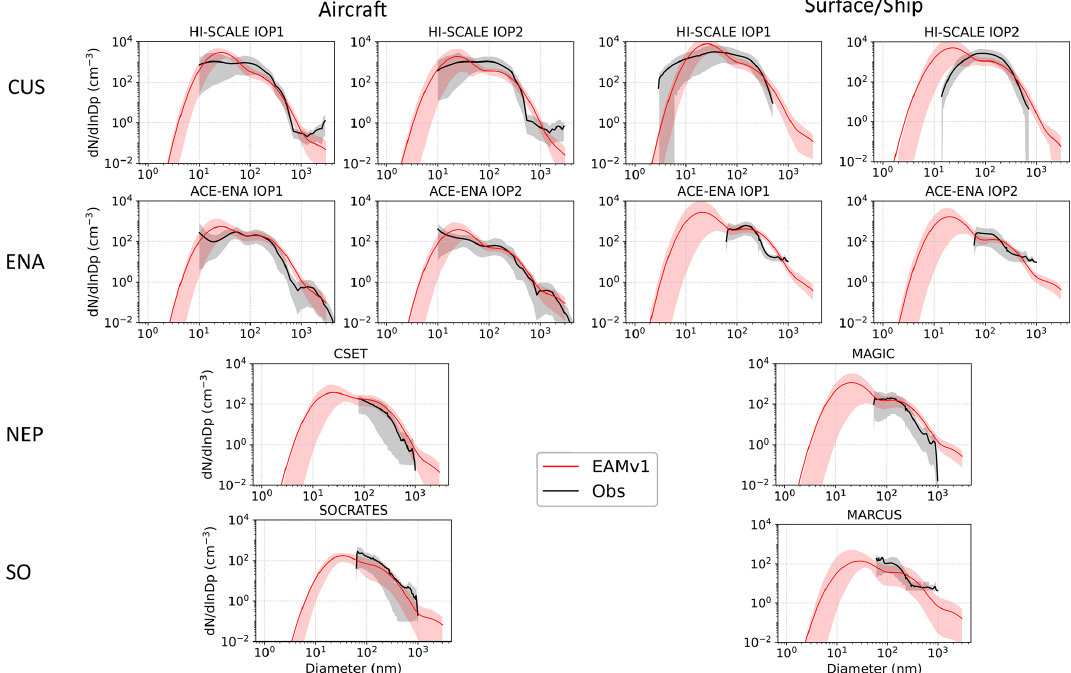
Figure 5. Mean aerosol number distribution averaged for each field campaign or IOP. Shadings denote the range between the 10th and 90th percentiles.